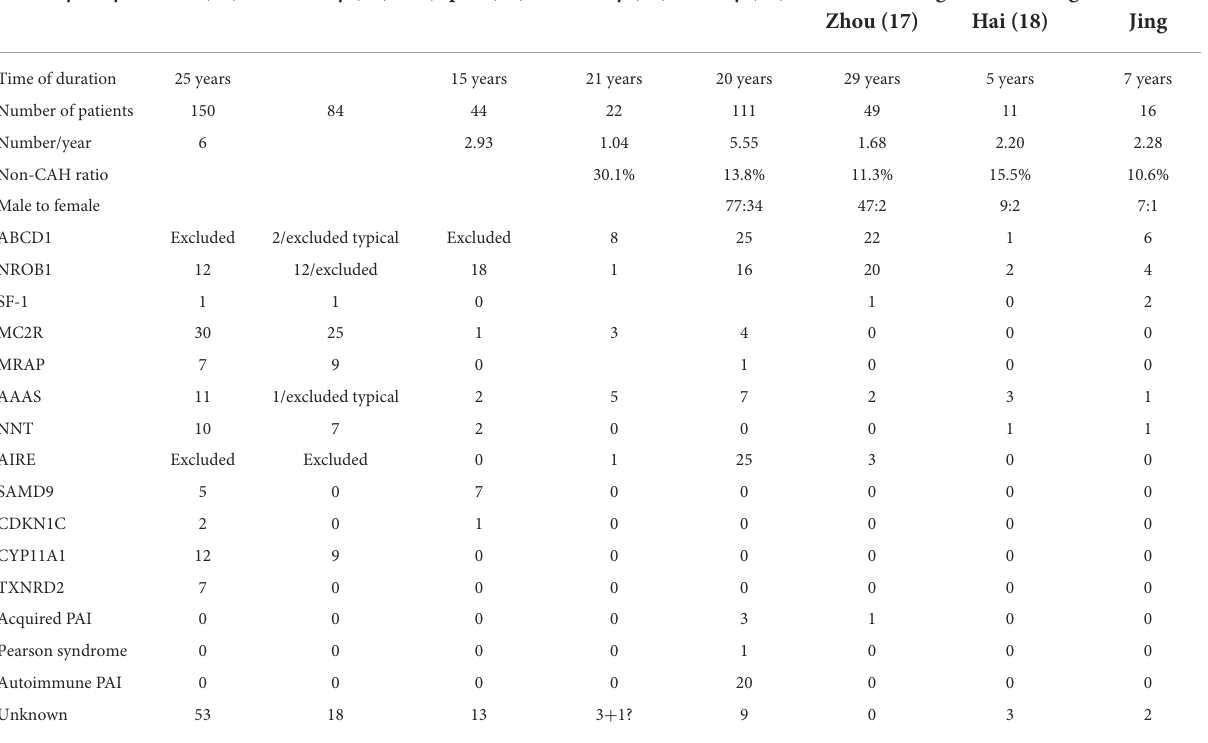
TABLE 3 Composition of primary diseases in different countries or regions.